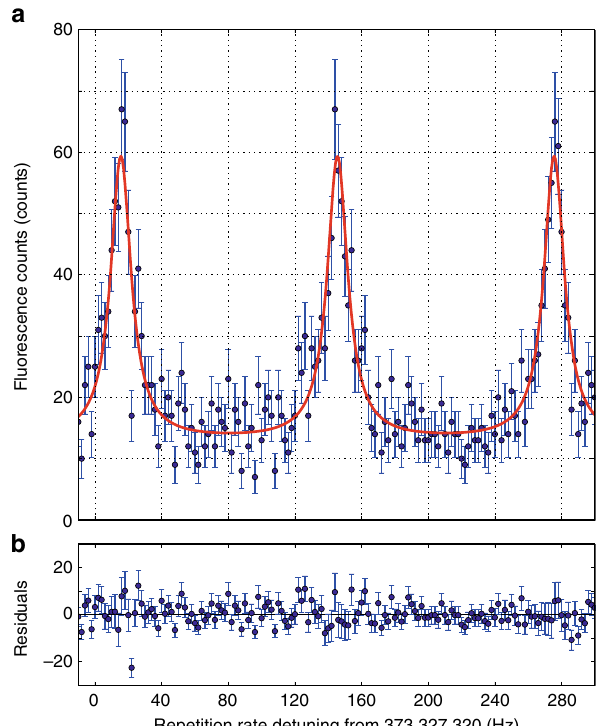
Fig. 3 Typical spectroscopy signal. a The longitudinal modes of the frequency comb are scanned over the 25 Mg + D 2 resonance by changing the repetition rate while the fl uorescence from an individual ion is collected. The signal is periodic just as the comb is. To convert the detuning of the repetition rate to optical frequency one needs to multiply with the mode number which is n = 2,871,702 for the central peak. The photon count rate at the peak of resonance was ~7 Hz. The signal was accumulated to give a larger signal count. The data are fi tted with a series of Lorentzians as indicated by a solid red curve and the fi t residuals are shown in b . The linewidth of the signal peaks is about 43 MHz in good agreement with the natural linewidth of 41.8 MHz 40 . The error bars are taken as the square root of the signal counts assuming Poissonian statistics for both a and b